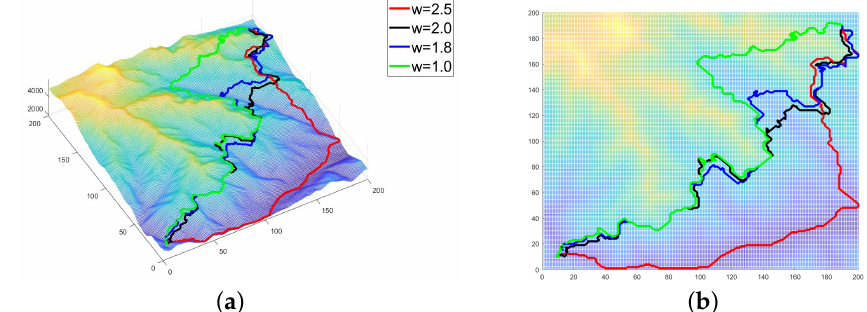
Figure 10. RA* without safety map. ( a ) Three-dimensional view. ( b ) Top